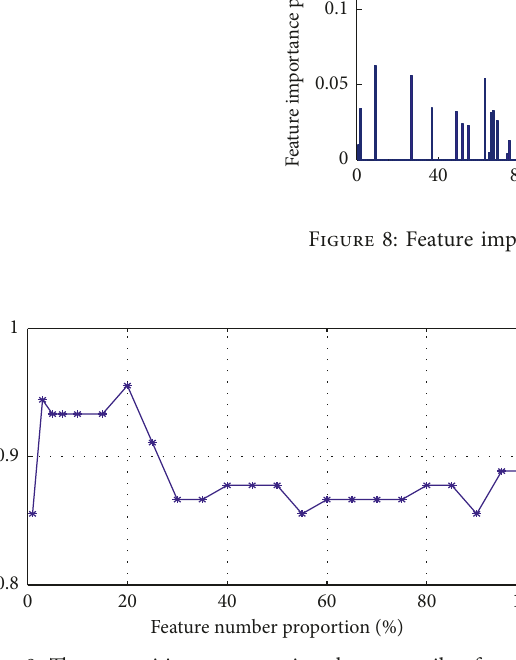
Figure 9: The recognition rates varying the percentile of texture features